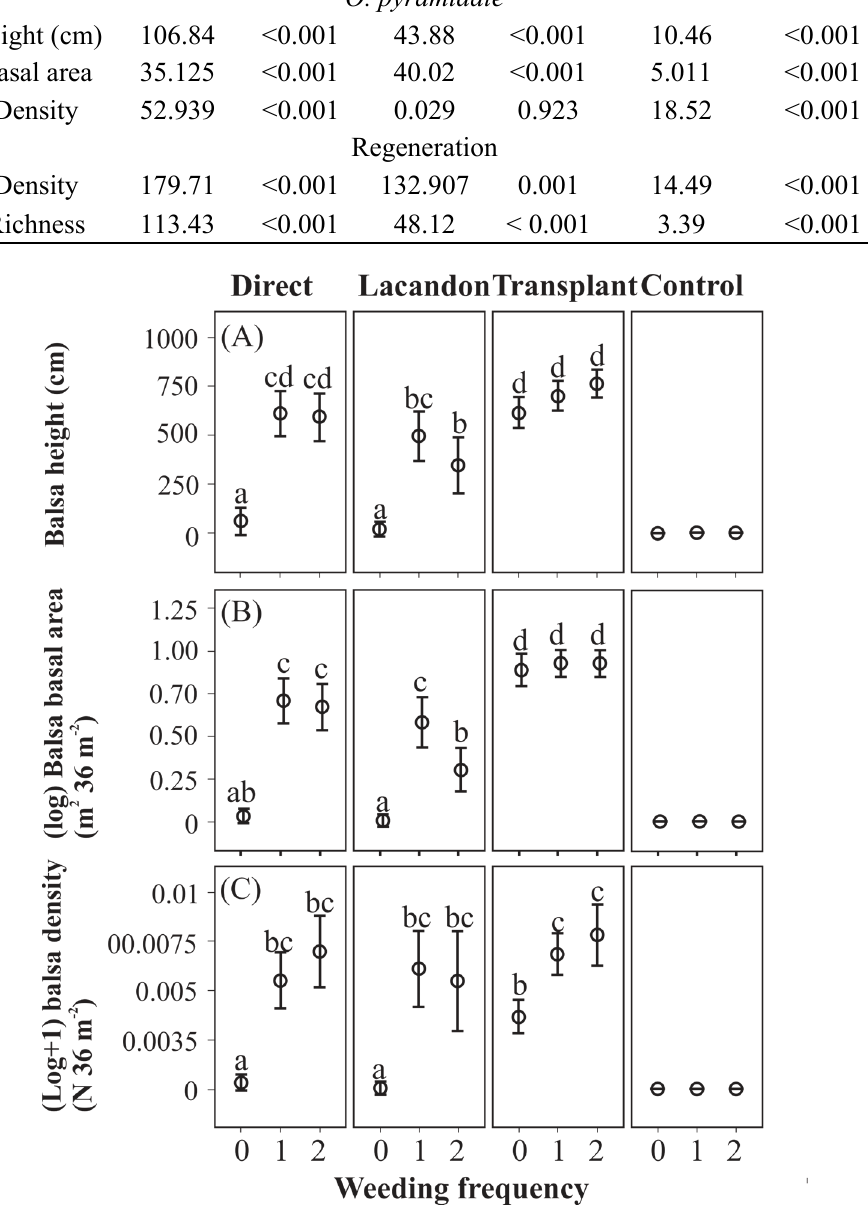
Figure 3. ( A ) Mean and 95% confidence interval of balsa ( Ochroma pyramidale ) tree height (cm); ( B ) basal area (36 m − 2 ); and ( C ) density (36 m − 2 ) per treatment and